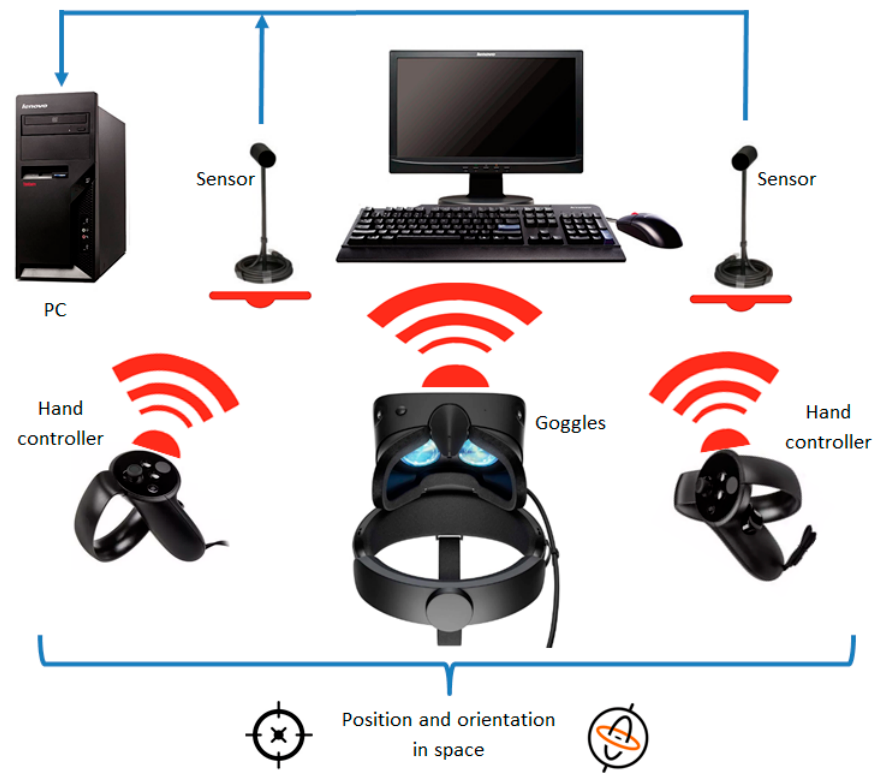
Figure 2. The idea of functioning of the virtual reality system.